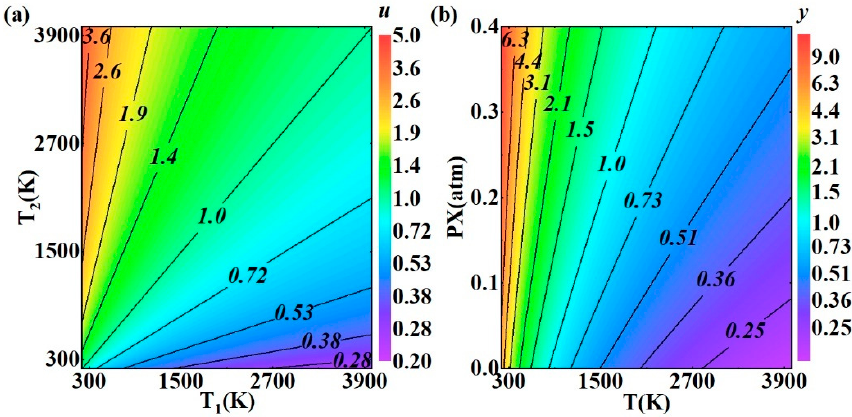
Figure 2. Typical applications: ( a ) range of the normalization coefficient ratio and ( b ) range of the line damping parameter.